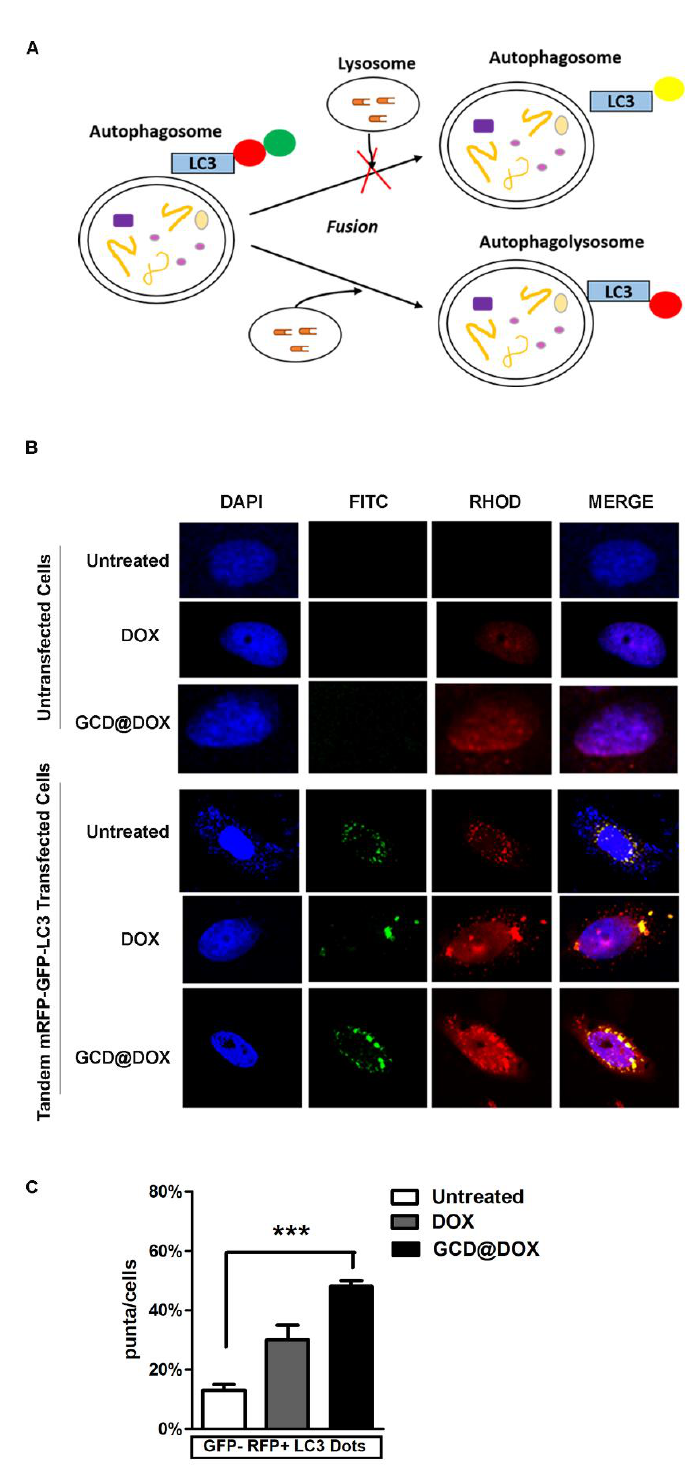
Figure 6. Monitoring of the double-tagged LC3 by mRFP-GFP-LC3 tandem fluorescent protein. ( A ) Graphical representation of mRFP-GFP-LC3 tandem. ( B ) Representative confocal images of HEp-2 cells untransfected and transiently transfected with mRFP-GFP tandem fluorescent-tagged LC3 and untreated or treated with DOX (1.25 µ g/mL) and GCD@DOX (25 µ g/mL) for 48 h (magnification, 63X). ( C ) Quantification of GFP − /RFP + /LC3 dots represented as percentage (%) in HEp-2 untreated and treated with DOX and GCD@DOX. Statistical significance was tested by one-way ANOVA analysis assay in triplicate (*** p <